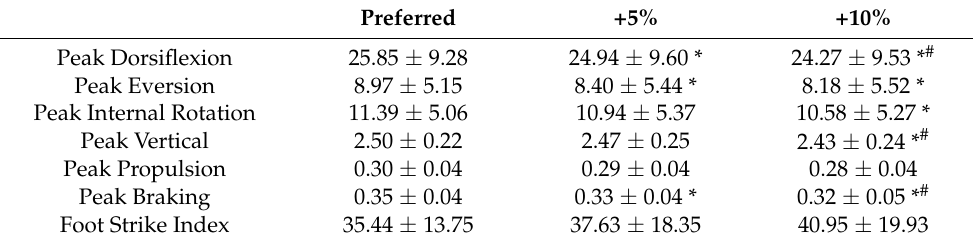
Table 2. Peak rearfoot angles (degrees), peak tibial internal rotation (degrees), peak vertical, propul- sion, and braking ground reaction forces (BW), and foot strike index (% of foot length) at initial contact for the preferred, +5%, and +10% step rate conditions.